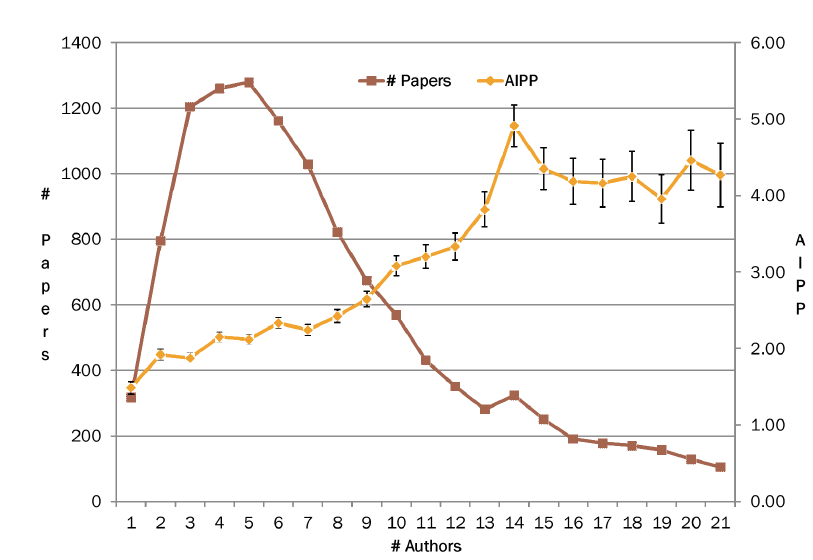
Figure 3. Average impact per paper and the number of papers by